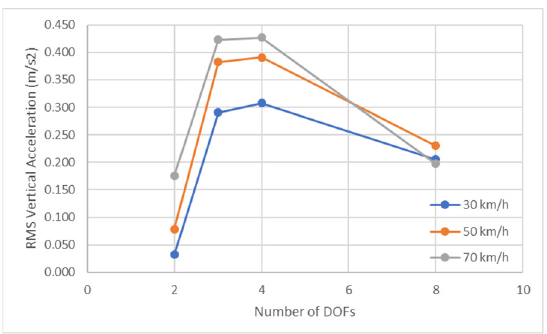
Figure 12. The RMS value of the acceleration of the top DOF for the periodic disturbance.